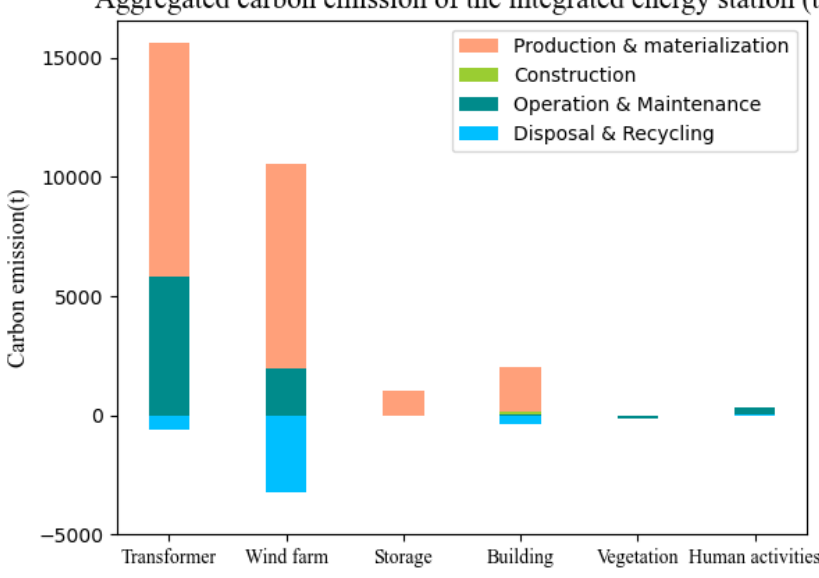
Figure 4. Aggregated carbon emission of the IES.